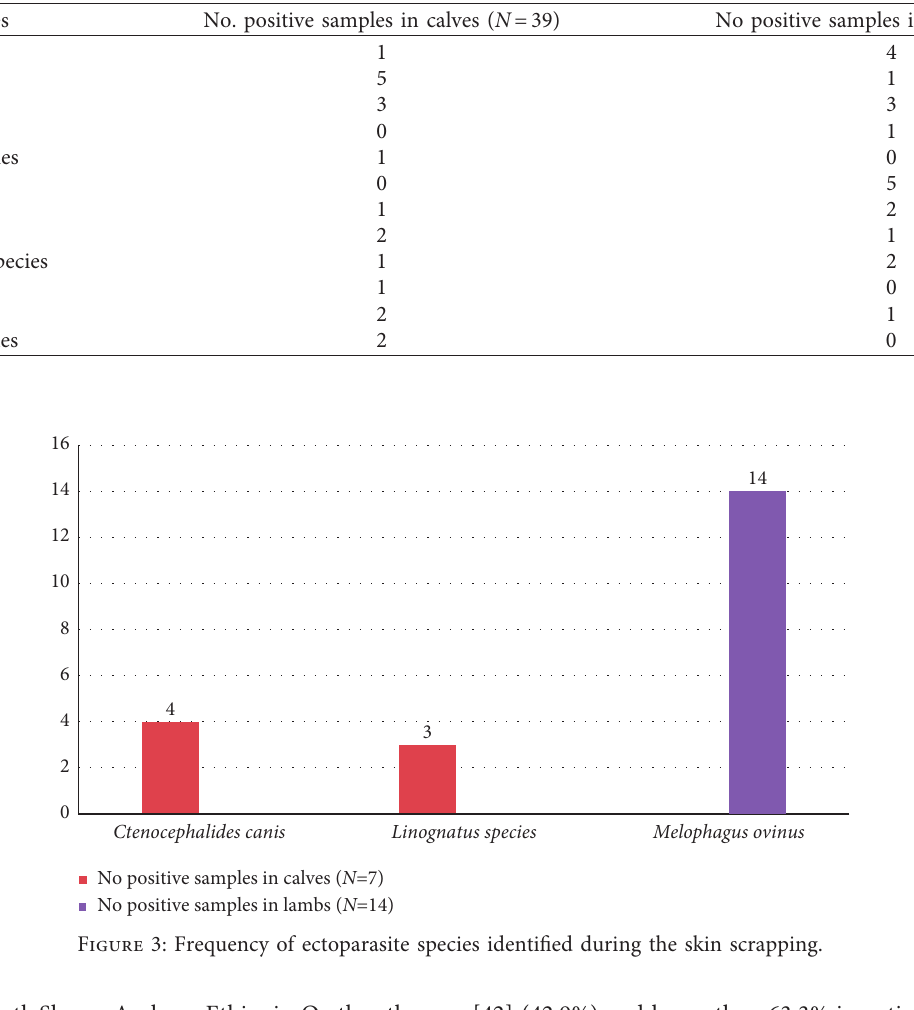
Table 8: List of helminths eggs identified during the fecal